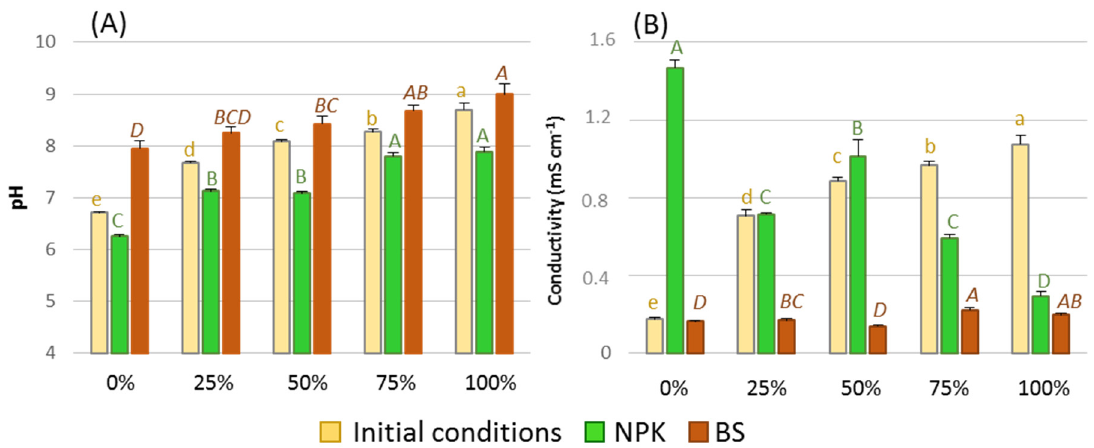
Figure 1. Substrate pH ( A ) and electric conductivity ( B ) values. Yellow bars, initial substrate conditions; green bars, NPK-treated substrate at the end of the experiment; brown bars, BS-treated substrate at the end of the experiment. Different letters indicate significant differences using Duncan’s test ( p < 0.05; n = 6) within each condition: initial (Yellow lowercase letters), NPK-treated (green uppercase letters) and BS-treated (brown uppercase bold letters).